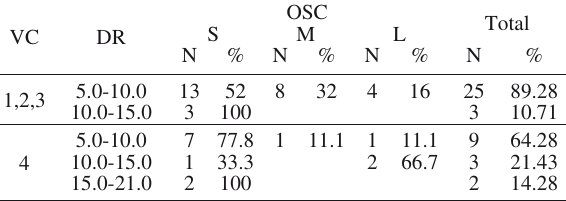
Table 3. – Octopus vulgaris size distribution by depth in the Rodas inlet. VC, visual census number; DR, depth range (m); OSC,